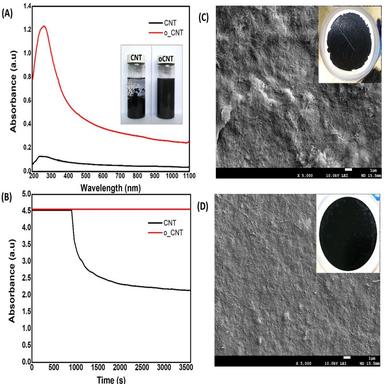
Aqueous dispersion (A) and stability (B) of MWCNT nanofluid and SEM image of MWCNT BP made of poor (A) and well (A) dispersed nanofluid.